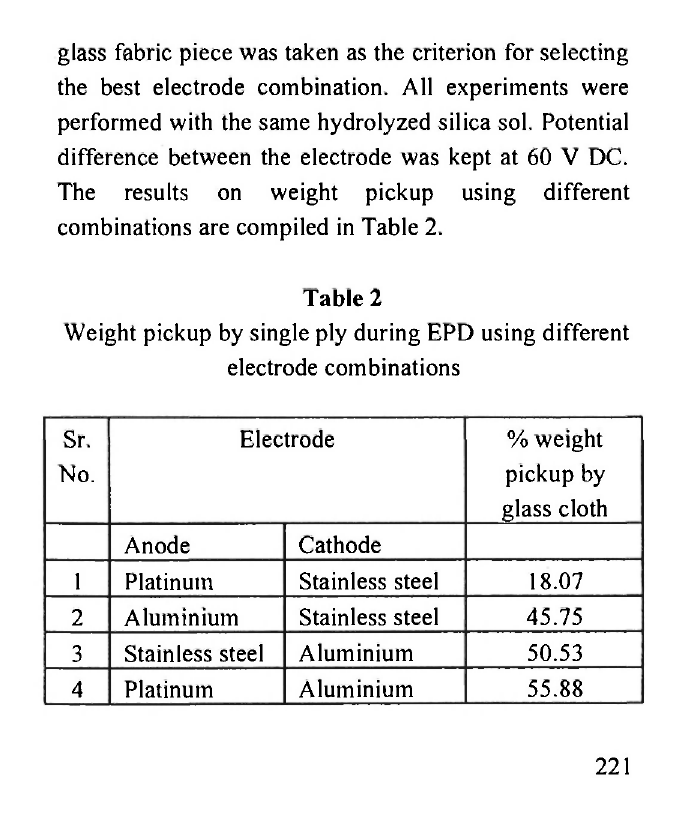
Fig. 1 : Schematic diagram of electrophoretic deposition cell used for infiltration of fabric perform